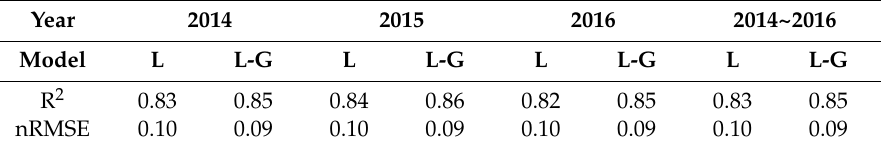
Table 2. Regression fitness of the Linear and Linear-Gompertz models by